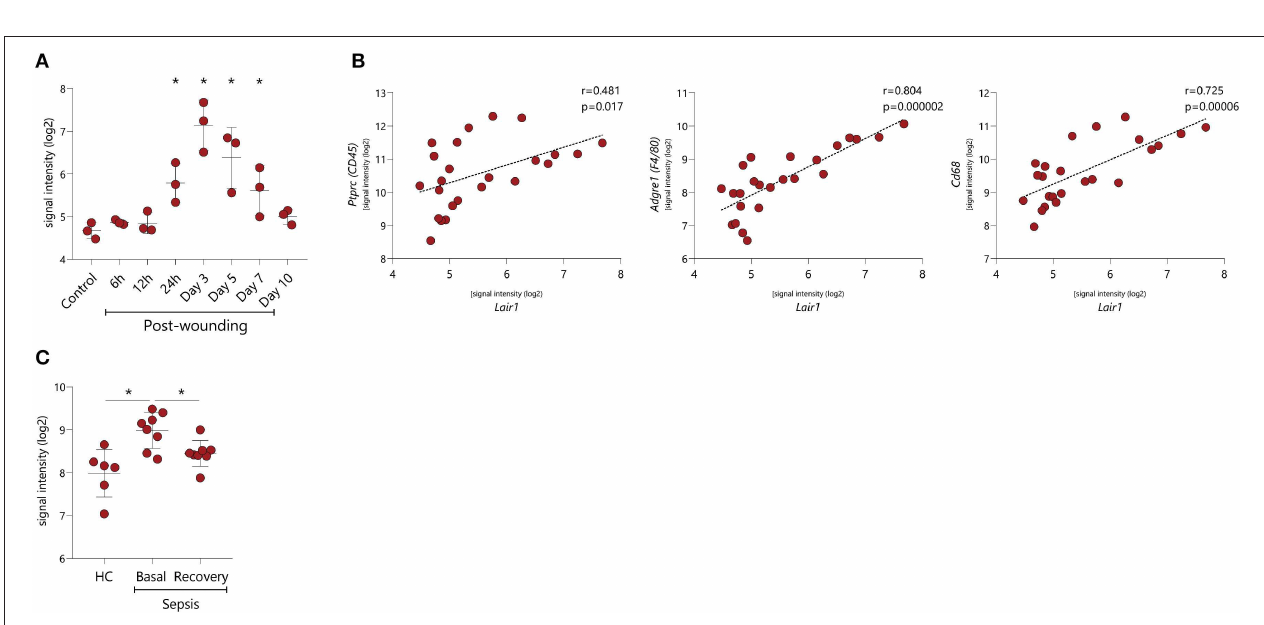
FIGURE 6 | LAIR-1 in vivo dynamics during inflammation. LAIR-1 gene expression was determined by array profiling and retrieved from publicly available datasets. (A) Lair1 expression in mouse skin samples recovered from injury up to 10 days following wounding inflicted via punch biopsy (GSE23006). Results are represented as mean with SD. Differences were considered statistically significant when * p < 0.05 vs. control sample (one-way ANOVA test). (B) Correlation between Lair1 expression and Ptprc (CD45), Adgre1 (F4/80), and Cd68 expression in mouse skin samples recovered from injury up to 10 days following wounding inflicted via punch biopsy (GSE23006). Correlations were assessed by the Pearson’s correlation coefficient test. (C) LAIR-1 expression on peripheral blood monocytes from gram-negative sepsis patients during sepsis and following their recovery (GSE46955). Results are represented as mean with SD. Differences were considered statistically significant when * p < 0.05 (HC vs. sepsis basal and HC vs. sepsis recovery Unpaired t -test, sepsis basal vs. sepsis recovery Paired t